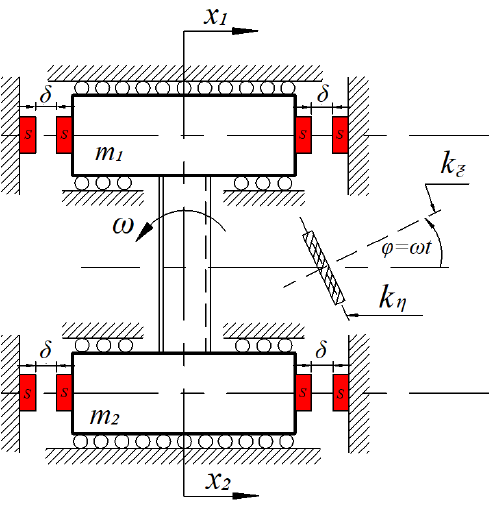
Figure 1. The Schematic representation of a system composed of two oscillators connected with periodically variable stiffness. (Color